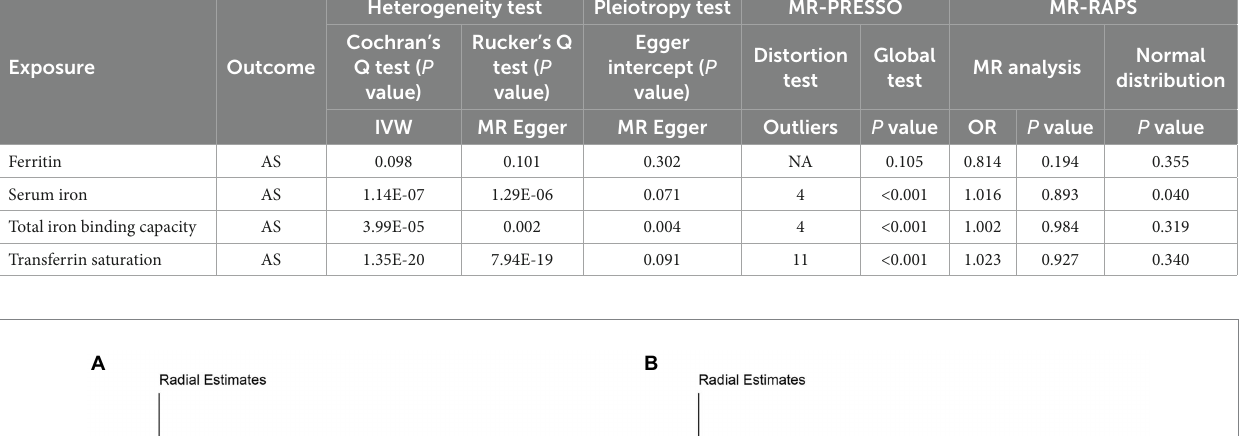
TABLE 2 Sensitivity analysis of the MR analysis results of exposures and